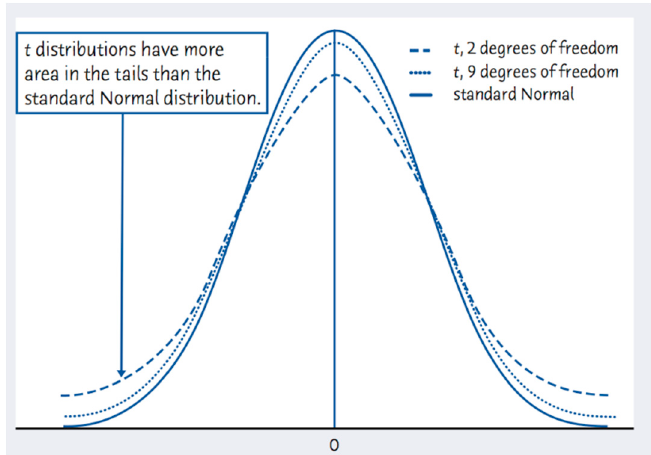
Figure 1 . Student t distribution is leptokurtic and has a fatter tail when compared to a standard normal normal distribution.